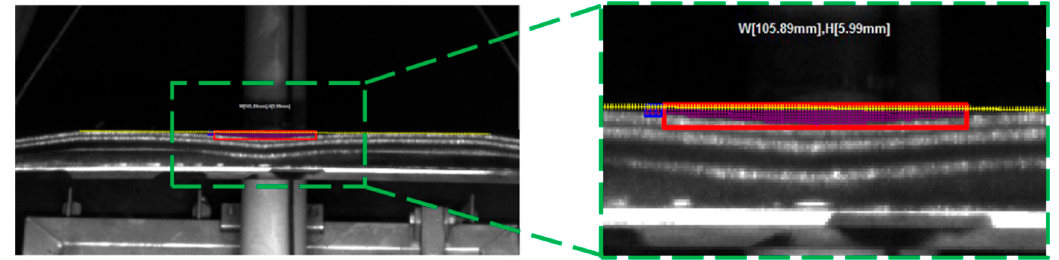
Figure 16. Result of wear measurement in normal contact strip.